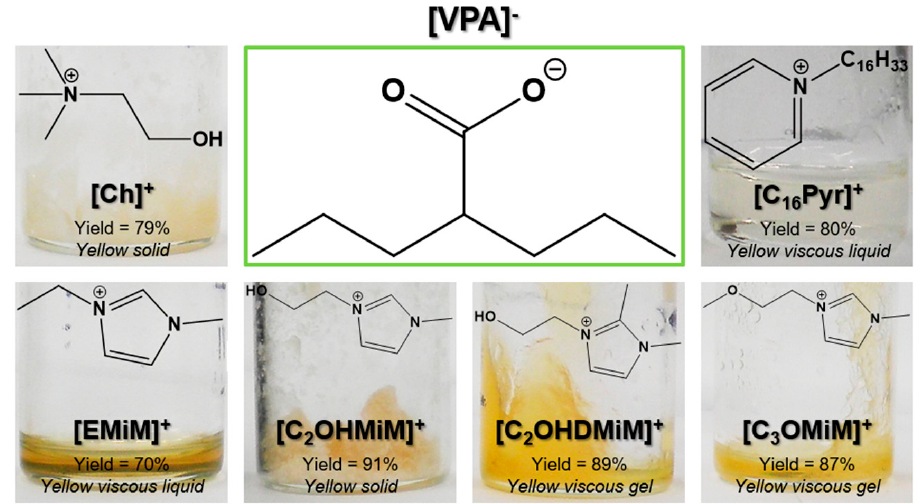
Figure 1. Structure, yield and physical state of the synthesized ionic liquids based on VPA.